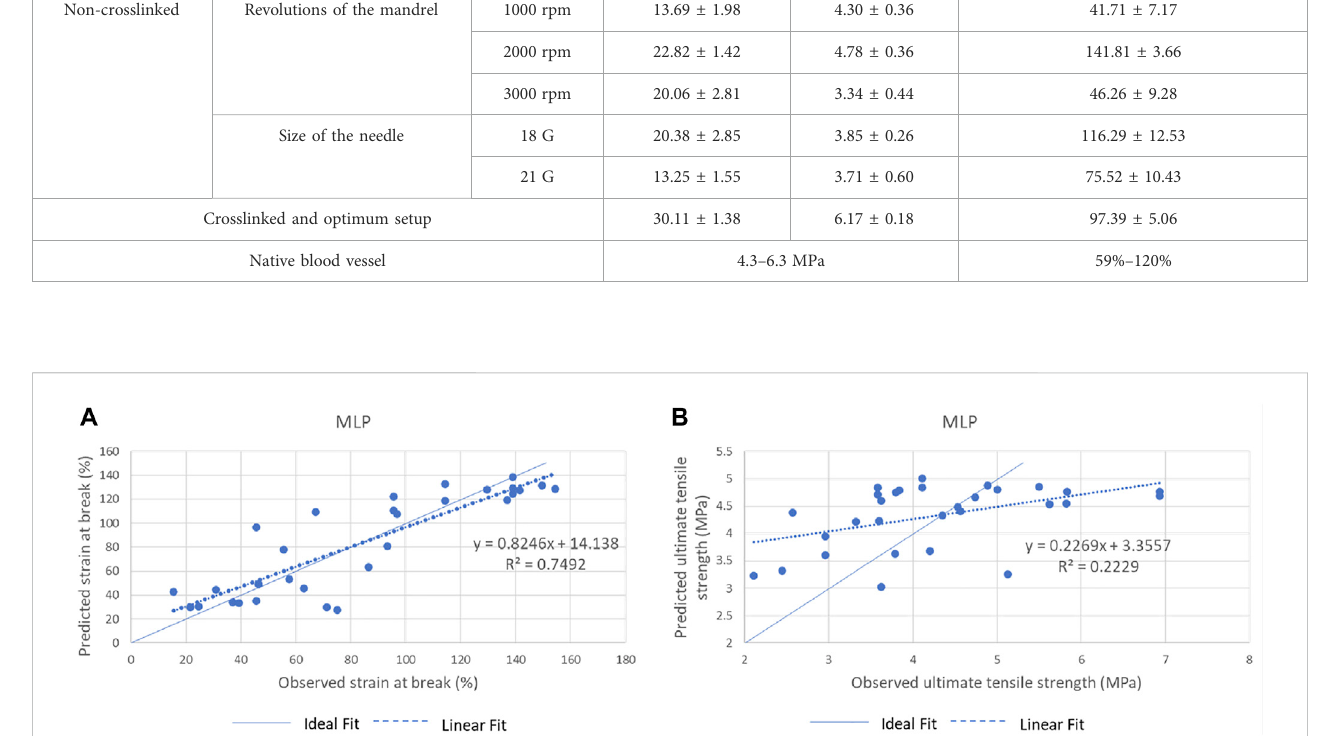
TABLE 4 Ultimate longitudinal and transverse tensile strength and transverse strain at break. Non-crosslinked